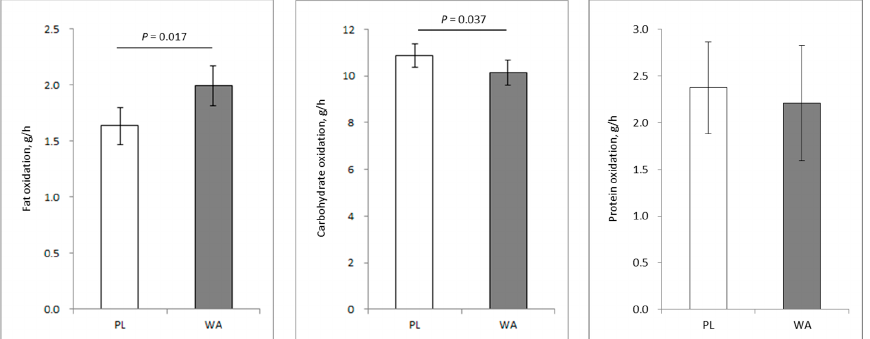
Figure 2. ( Left ) Fat oxidation. ( Middle ) Carbohydrate oxidation. ( Right ) Protein oxidation. Data are means ± standard errors during the night from 22:00 hour to 06:30 hour. Significant differences between the treatments were assessed with a mixed model adjusted by order of treatment.